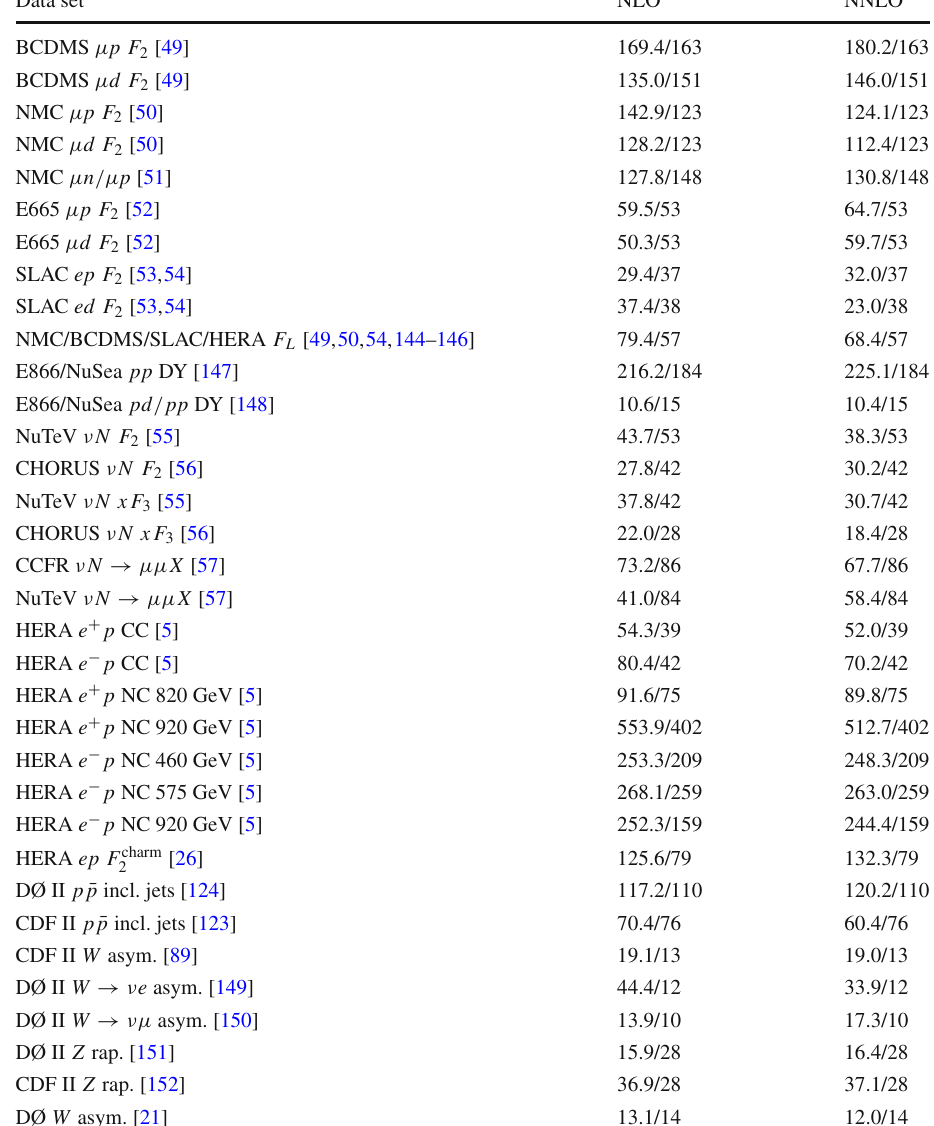
Table 6 The values of χ 2 / N pts. for the non-LHC data sets included in the global fit at NLO and